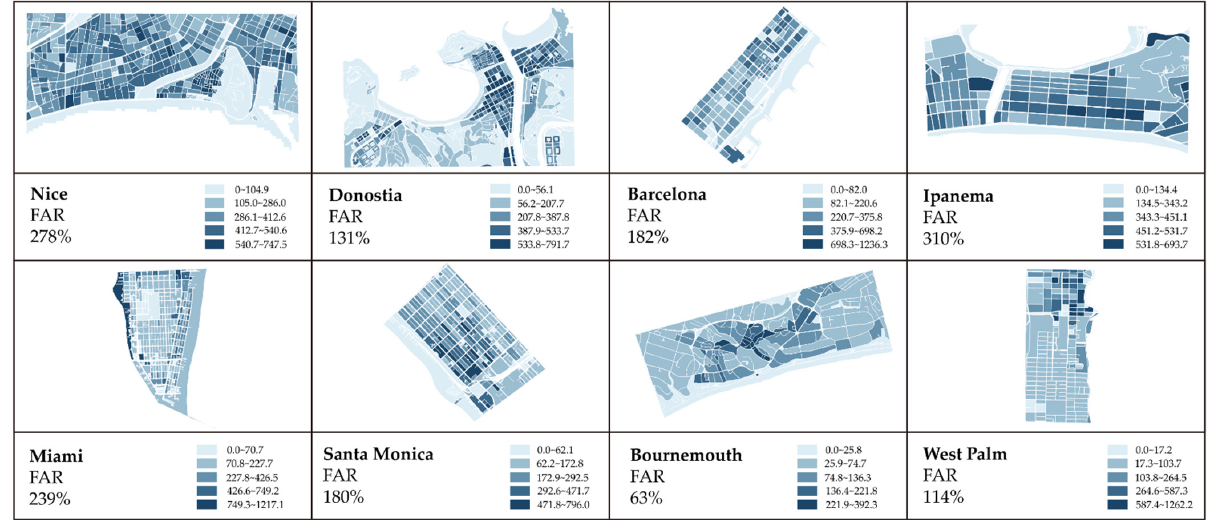
Figure 11. The distribution of FAR in successful coastal cases.